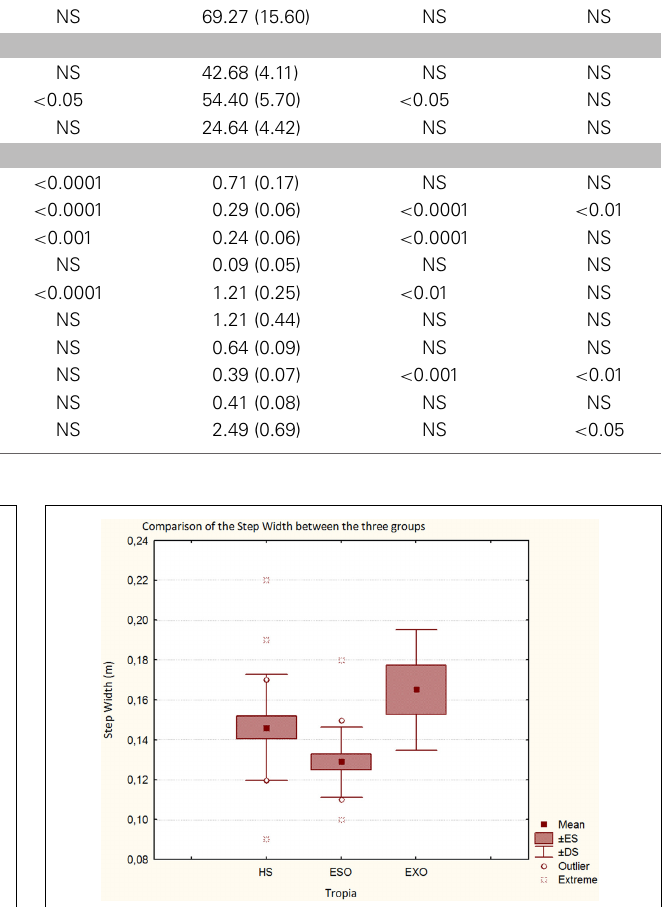
HS ( p < 0 . 05). A reduction (though not statistically significant) of the hip ROM was found between patients with EXO and HS and of the hip and ankle ROM comparing ESO and EXO groups.